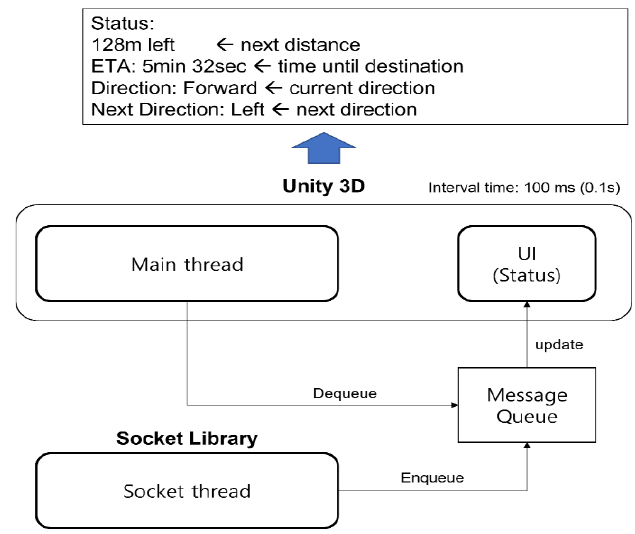
Figure 7. Status window processes.